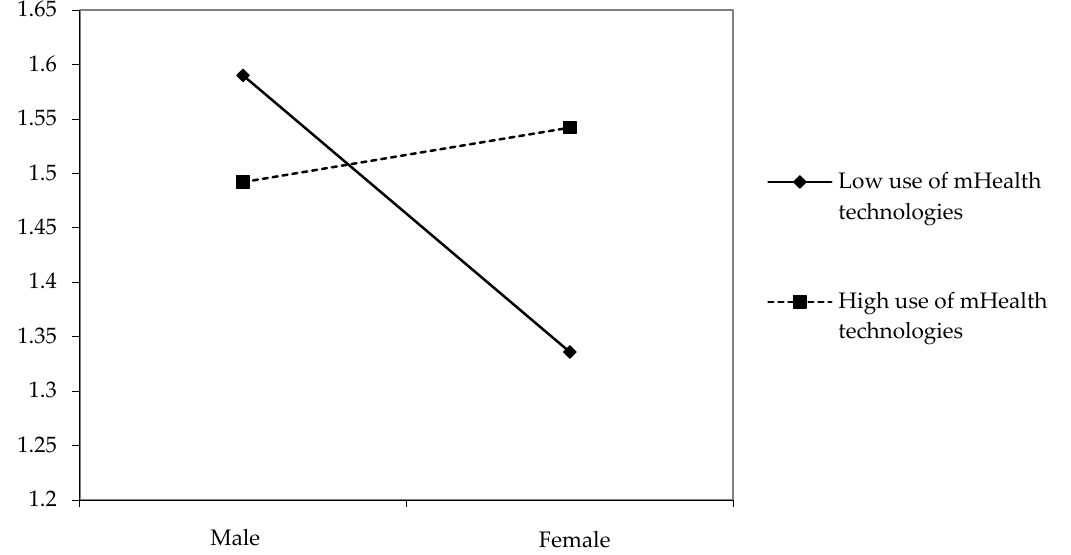
Figure 4. Interaction effects between gender and use of mHealth technologies on health status.